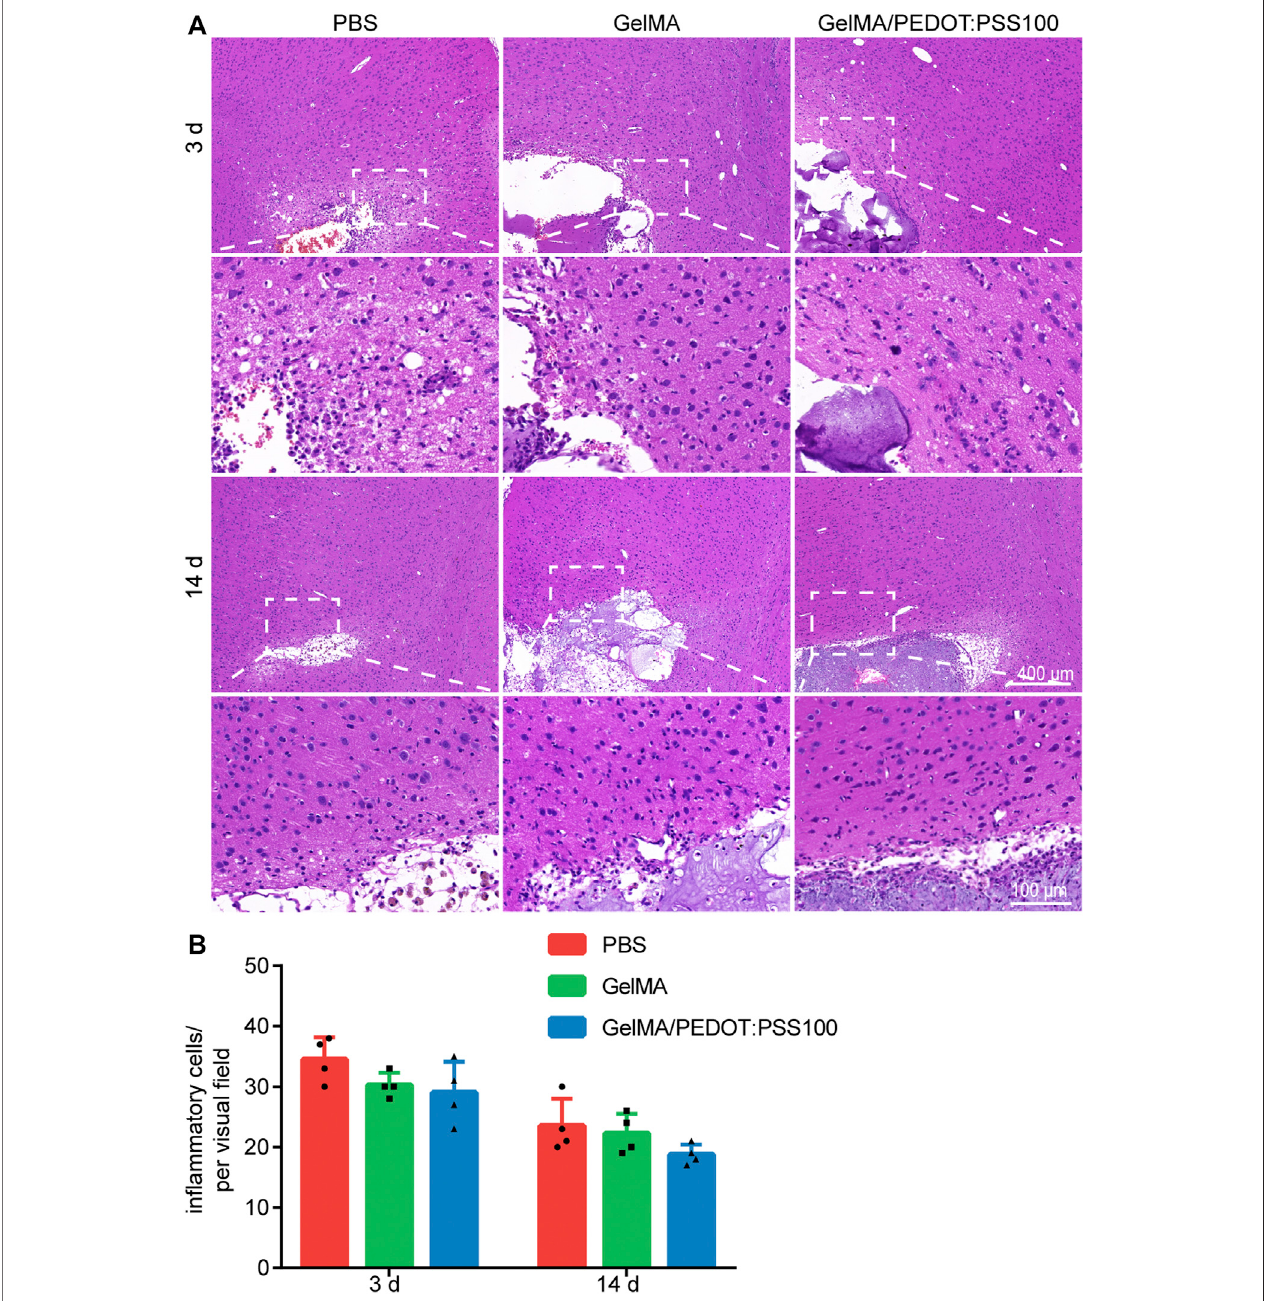
FIGURE 6 | HE staining images of different hydrogel groups 3 and 14 days after implantation. (A) HE staining on day 3 and 14. (B) Statistics of in fl ammatory cells. The data are expressed as mean ± SD.